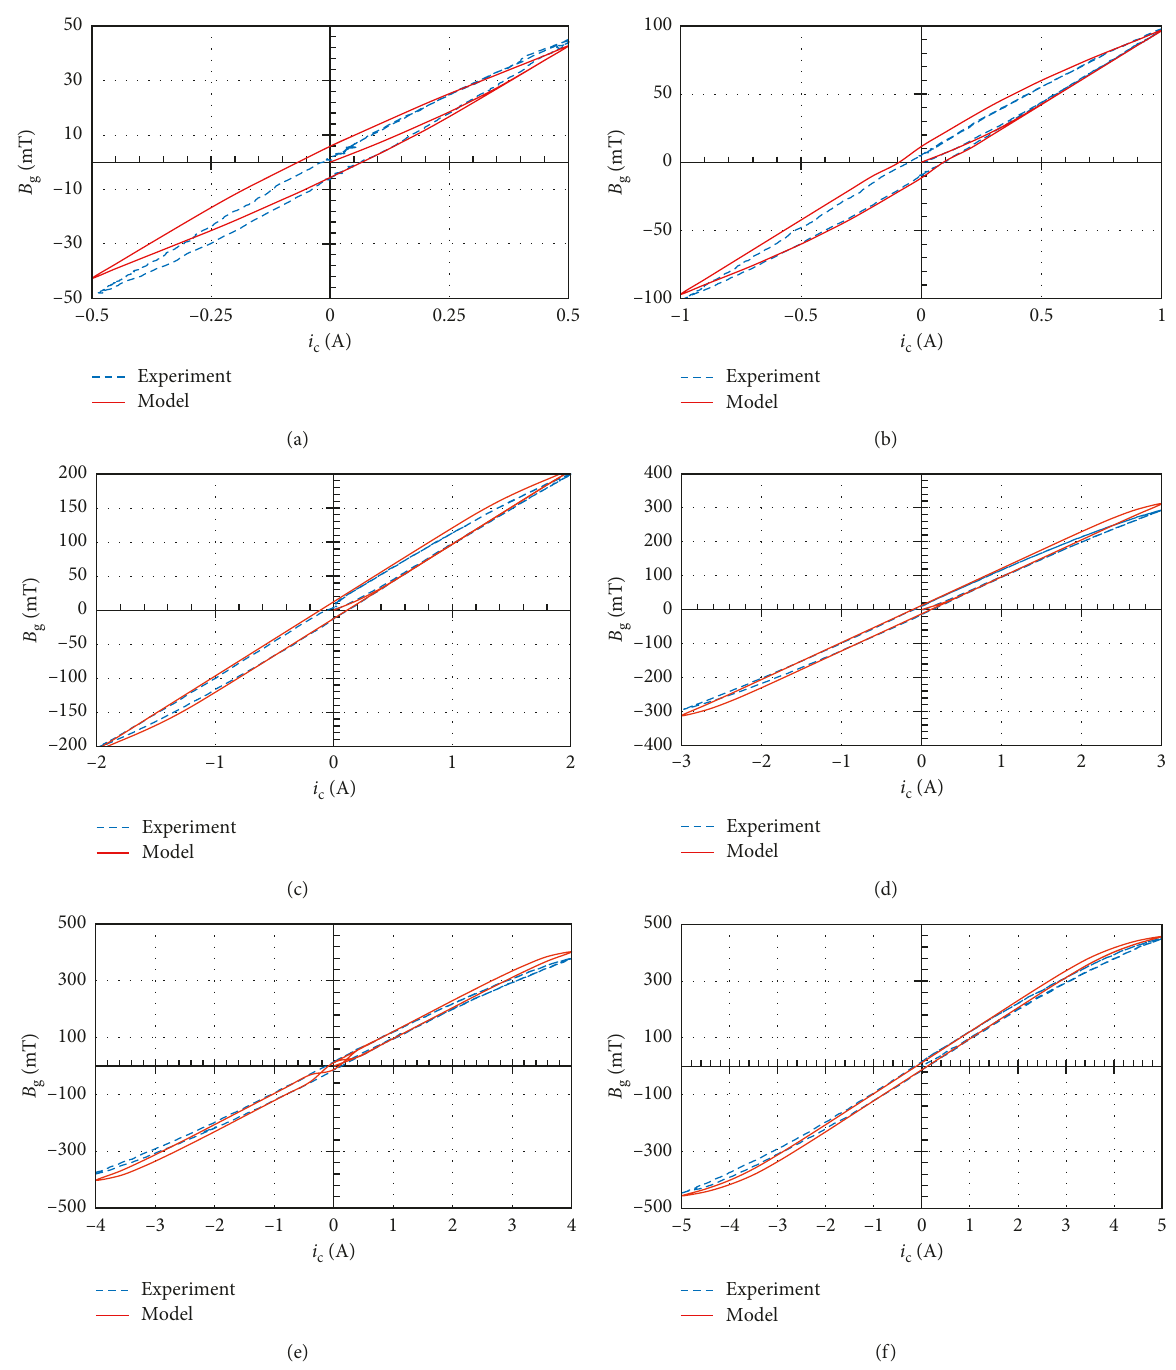
Figure 12: Air gap flux density: measurements vs FE model. (a) I (f) I max � 5.0